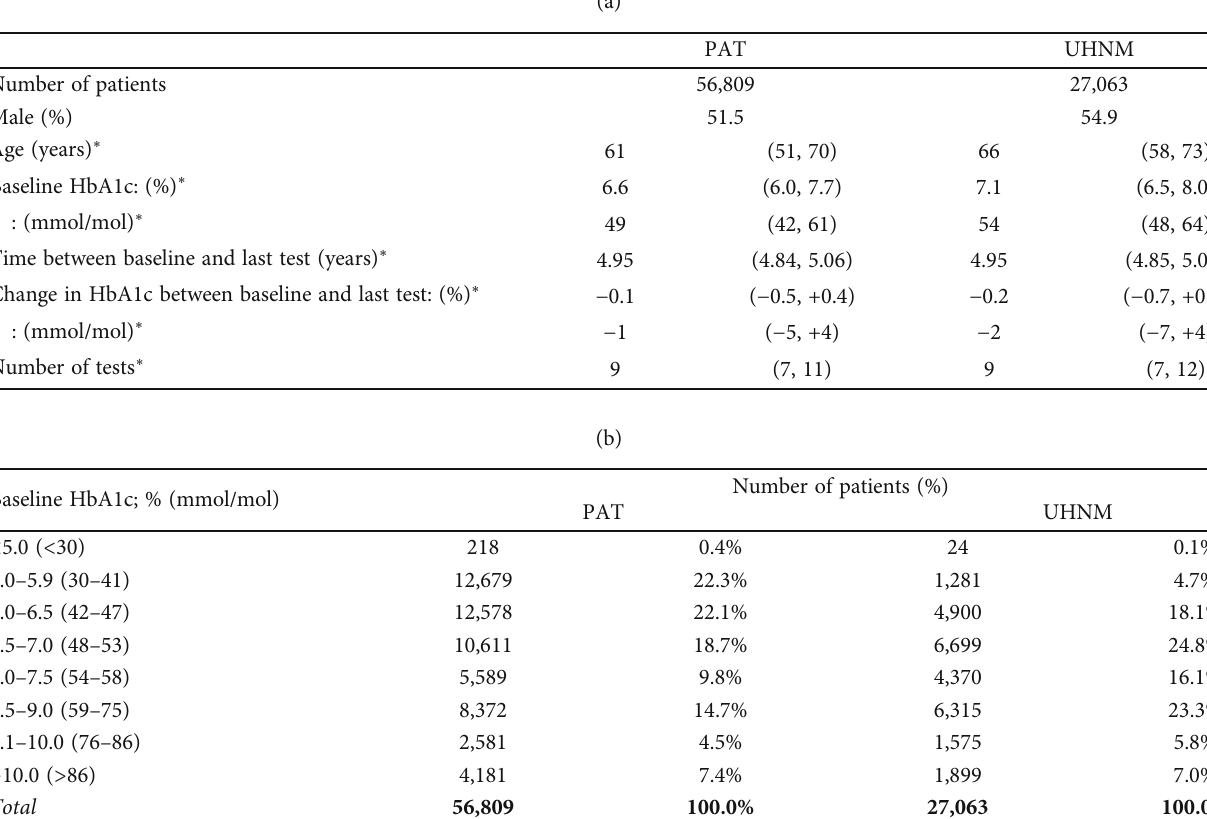
Table 1: Patient